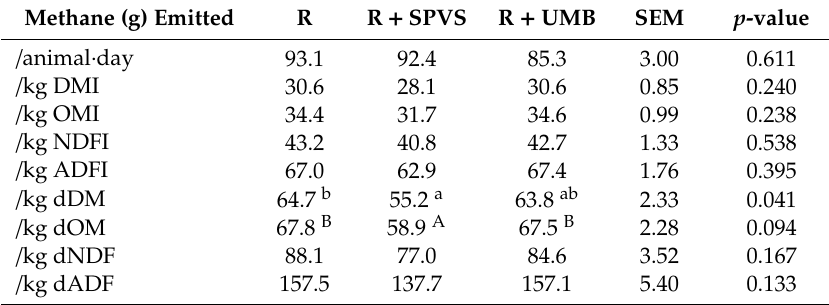
Table 6. Methane (CH 4 ) emissions by heifers fed with roughage (R) 1 alone or supplemented with sweet potato vine silage (R + SPVS) or urea-molasses blocks (R + UMB).